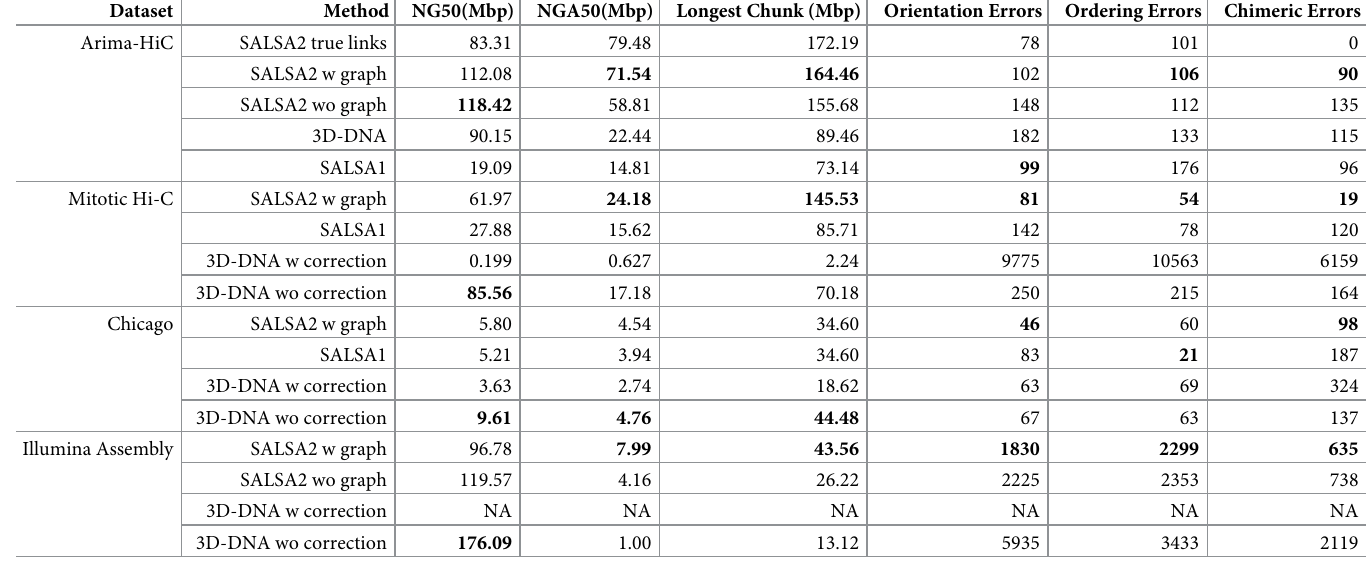
Table 2. Scaffold and correctness statistics for NA12878 assemblies scaffolded with different Hi-C libraries. “True links” is an idealized case where the Hi-C links have been filtered in advance. The NG50 of human reference GRCh38 is 145 Mbp. The ratio between NG50 and NGA50 represents how many erroneous joins affect large scaf- folds in the assembly. The bigger the difference between these values, the more aggressive the scaffolding was at the expense of accuracy. Longest chunk represents the lon- gest error-free portion of the scaffolds. We observed that the 3D-DNA mis-assembly detection was overly aggressive in some cases, and so we ran some assemblies both with and without this feature. For the Illumina assembly as an input, 3D-DNA w correction did not finish within two weeks and is omitted. An evaluation of a previously published [20] 3D-DNA assembly from short-read contigs is included in S3 Table but did not exceed SALSA2’s NGA50. Dataset